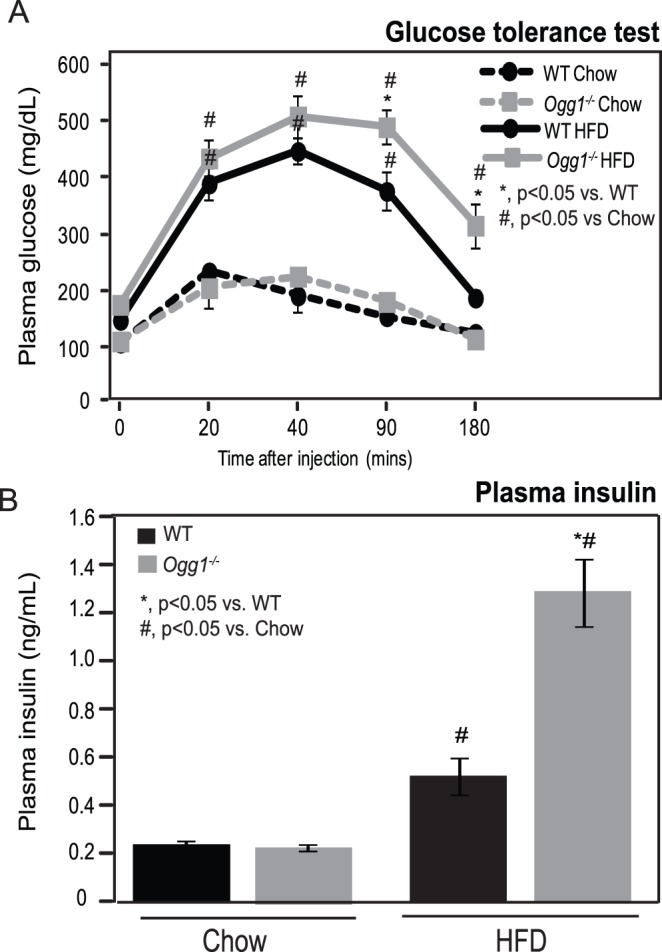
Glucose tolerance and plasma insulin.Glucose tolerance was measured by quantifying plasma glucose after an intraperitoneal injection of 1g glucose/kg BW in chow-fed and HFD-fed animals (A). Fasting plasma insulin was measured by ELISA prior to glucose injection (B). n = 6 for each group; *, p<0.05 vs. WT, #, p<0.05 vs. chow-fed mice.